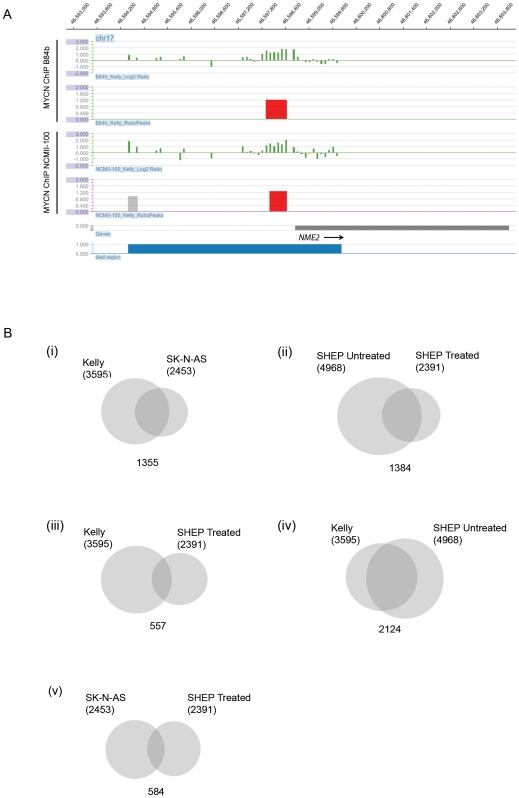
MYCN ChIP-chip.(A) Identification of MYCN binding upstream of NME2. The scale across the top of the panel indicates the base pair position on chromosome 17. Fluorescent intensity of probes from experiments using 2 independent MYCN antibodies around the NME2 promoter are expressed as log2 ratios (green bars) and high confidence MYCN peaks (red bars) as identified by the NimbleScan peak finding algorithm. Position of the NME2 transcript and the region tiled on the array are indicated by the bottom two panels. (B) Total number of MYCN peaks identified across neuroblastoma cell lines. Venn diagrams (i–v) display the number of MYCN peaks which is shared and unique to each cell line. Statistical significance of overlap for all comparisons was determined to be statistically significant (P<0.001) by Fisher's Exact Test.